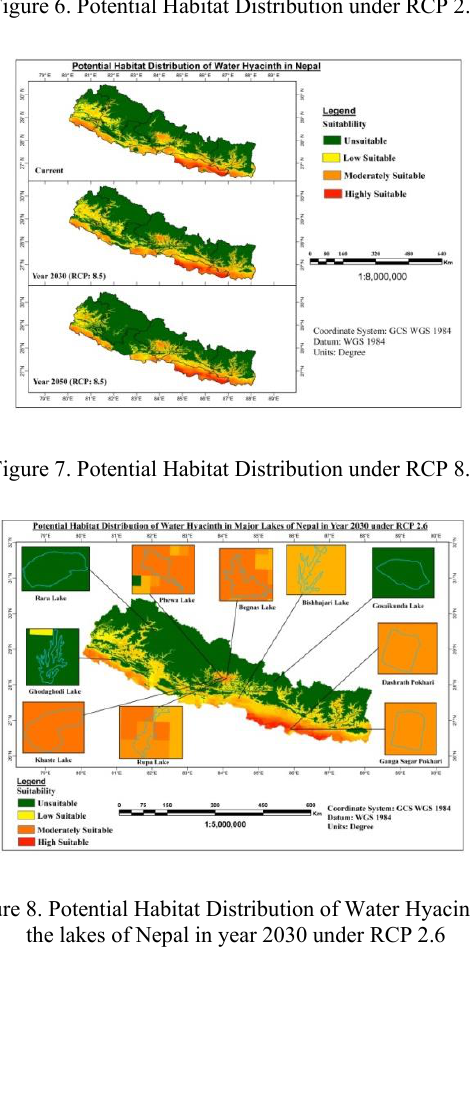
Figure 6. Potential Habitat Distribution under RCP 2.6